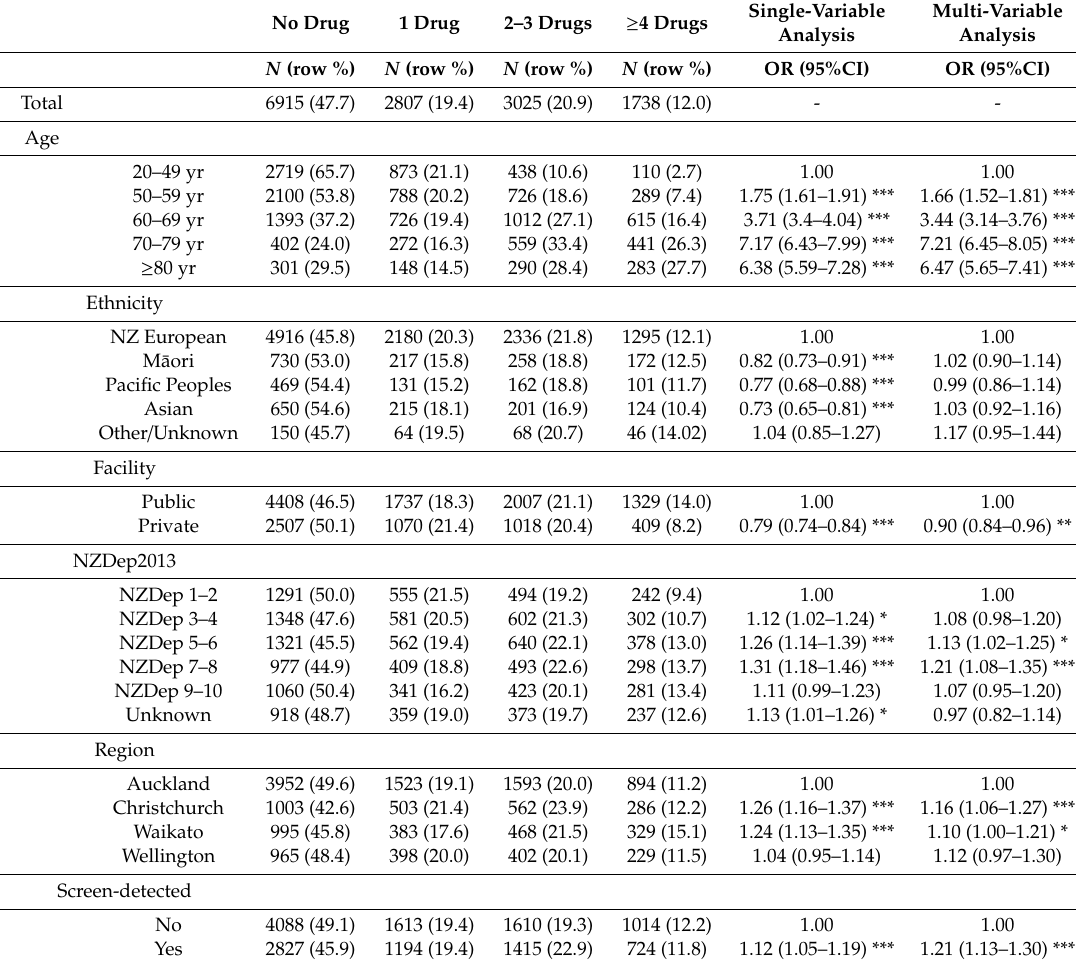
Table 3. Prevalence of medication use and associated demographic